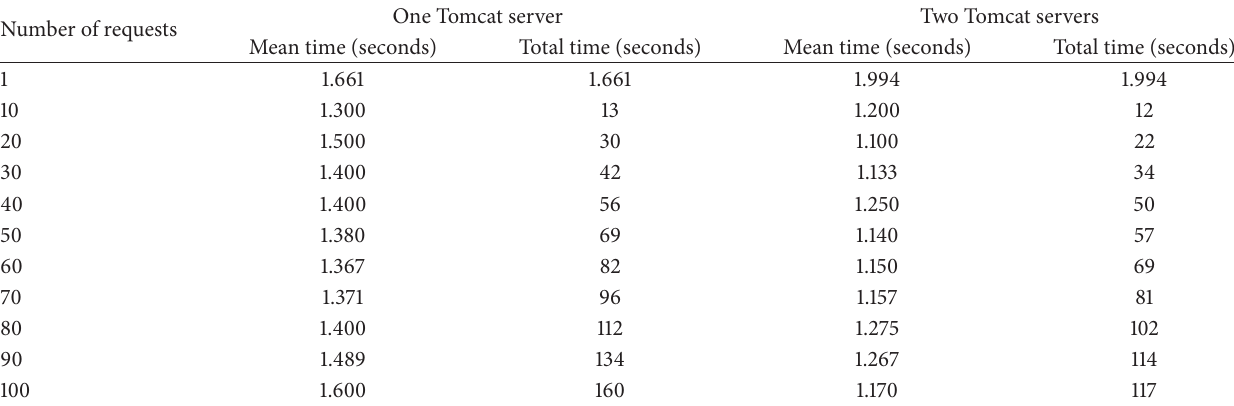
Table 2: Times required to submit different numbers of requests within 10 seconds when using the SSL